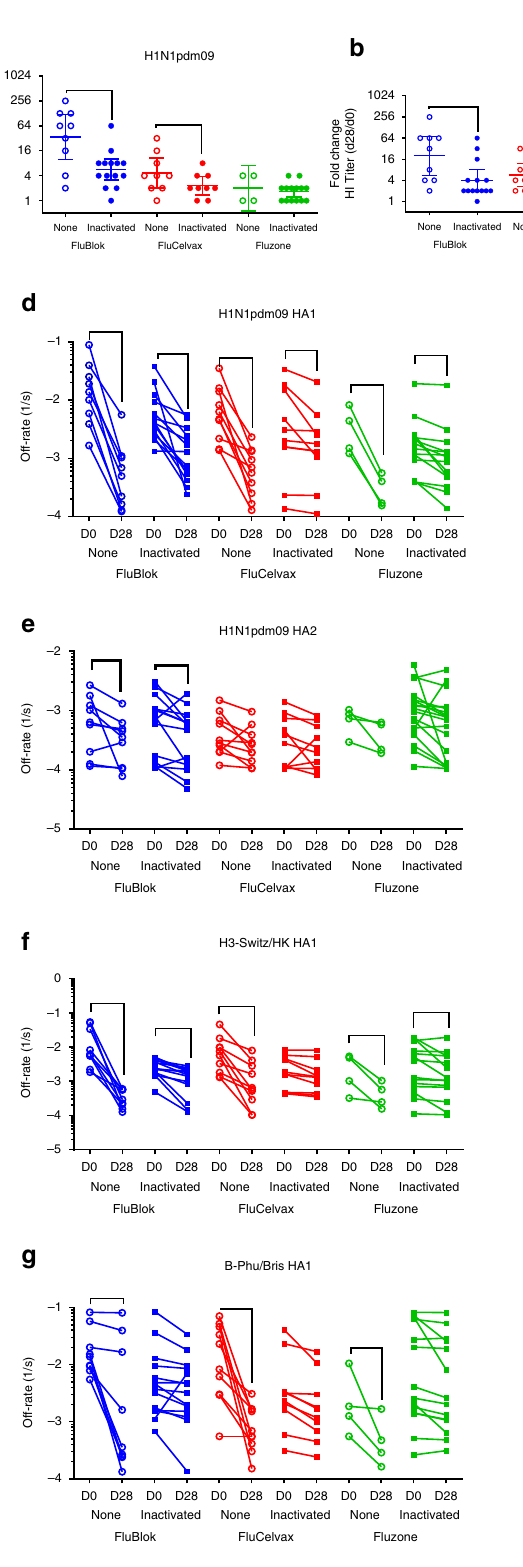
The negative impact of repeated in fl uenza vaccination on vaccine responsiveness and vaccine effectiveness (protection from infection) received increasing attention in recent years 33 – 37 . In the current study, only 16 individuals (15%) are vaccinated repeatedly with the same vaccine product in two consecutive years. The signi fi cant decline in the HI seroconversion rates